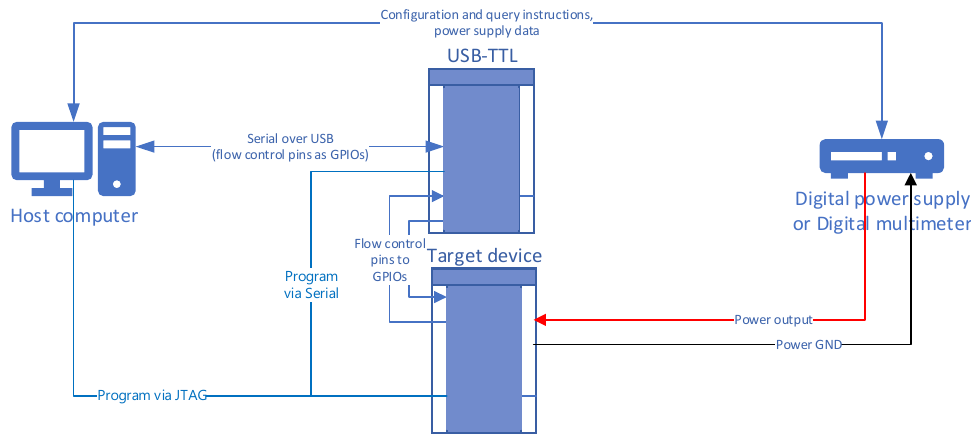
Figure 5. The architecture and wiring of the simplified auxiliary design.